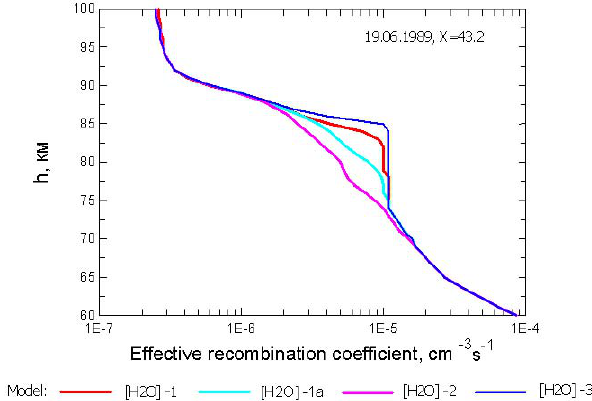
Fig. 7c. Effective recombination coefficient profiles for 19 June 1969 at 15:00UT, with a solar zenith angle of 43.2 ◦ , F 10 . 7 =149, and calculated for the H 2 O-1, H 2 O-1a, H 2 O-2 and H 2 O-3 profiles presented in Fig.